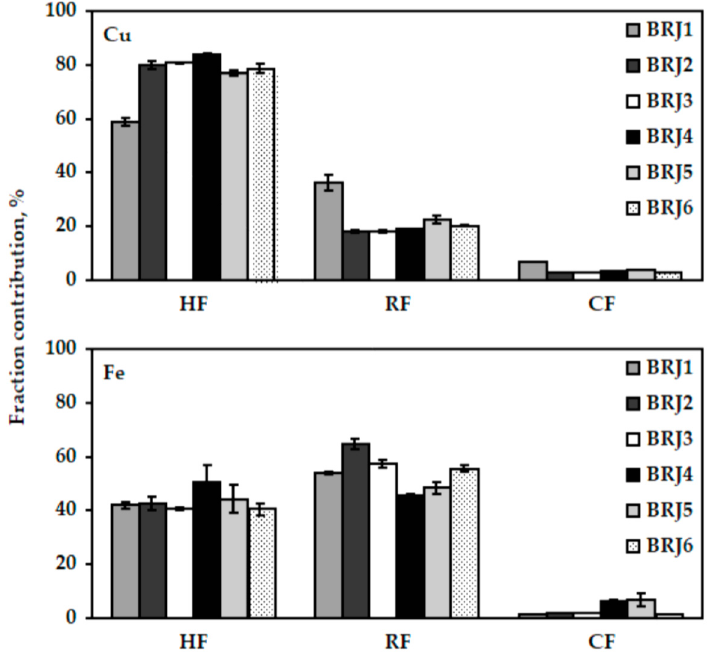
Figure 1. The contributions of the chemical fractions of the Cu and Fe species, i.e., the hydrophobic (HF), the residual (RF) and the cationic (CF), determined in the selected beetroot juices (BRJ1 − BRJ6) using the two-column solid-phase extraction (SPE) with the LC-18 and LC-SCX tubes.